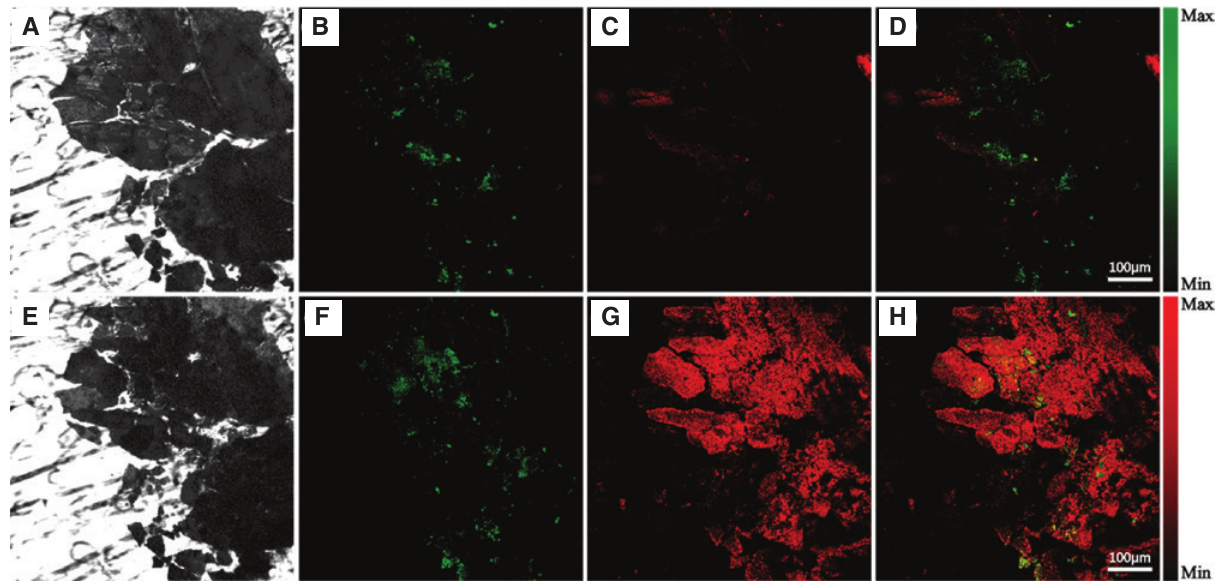
N . 3 4 N . (B) The TPEF (C) CARS and (D) merged images of g-C 3 4